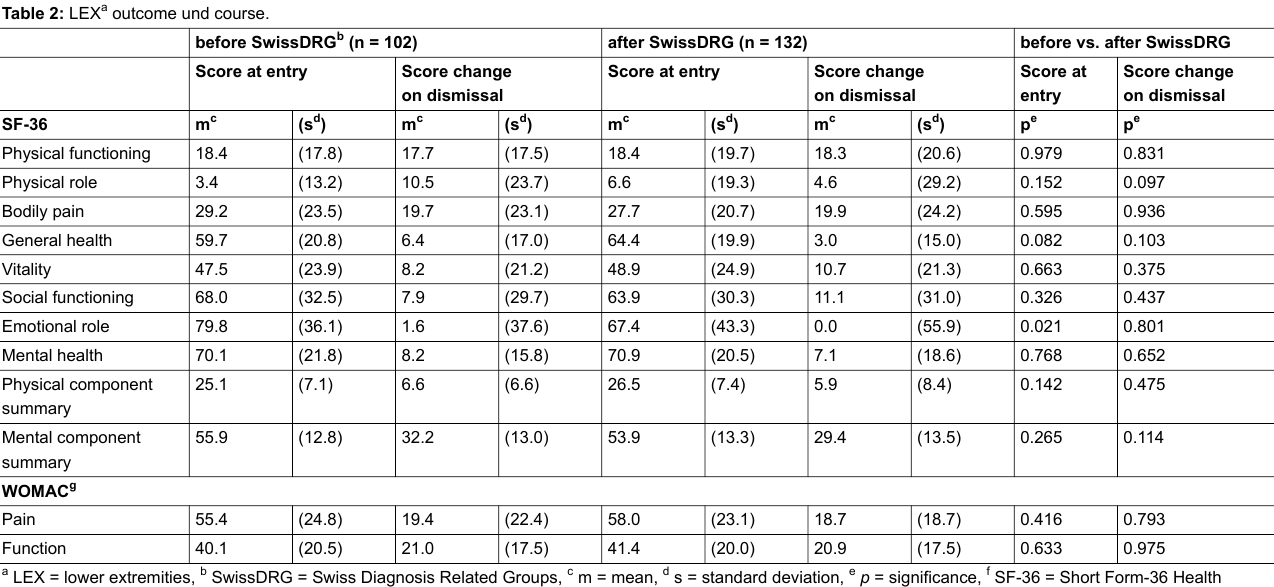
Table 2: LEX a outcome und course. before SwissDRG b (n = 102) after SwissDRG (n = 132) before vs. after